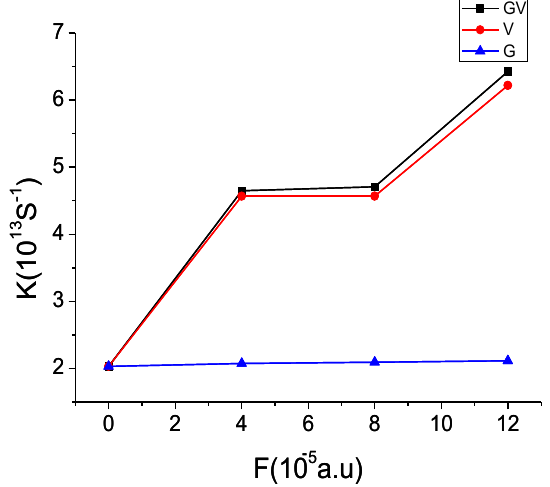
Figure 7. Calculated rates of CT under different electronic fields (a.u.), where blue, red and blank lines are )0(  FG , )0(  FV and combination of two factors, DA